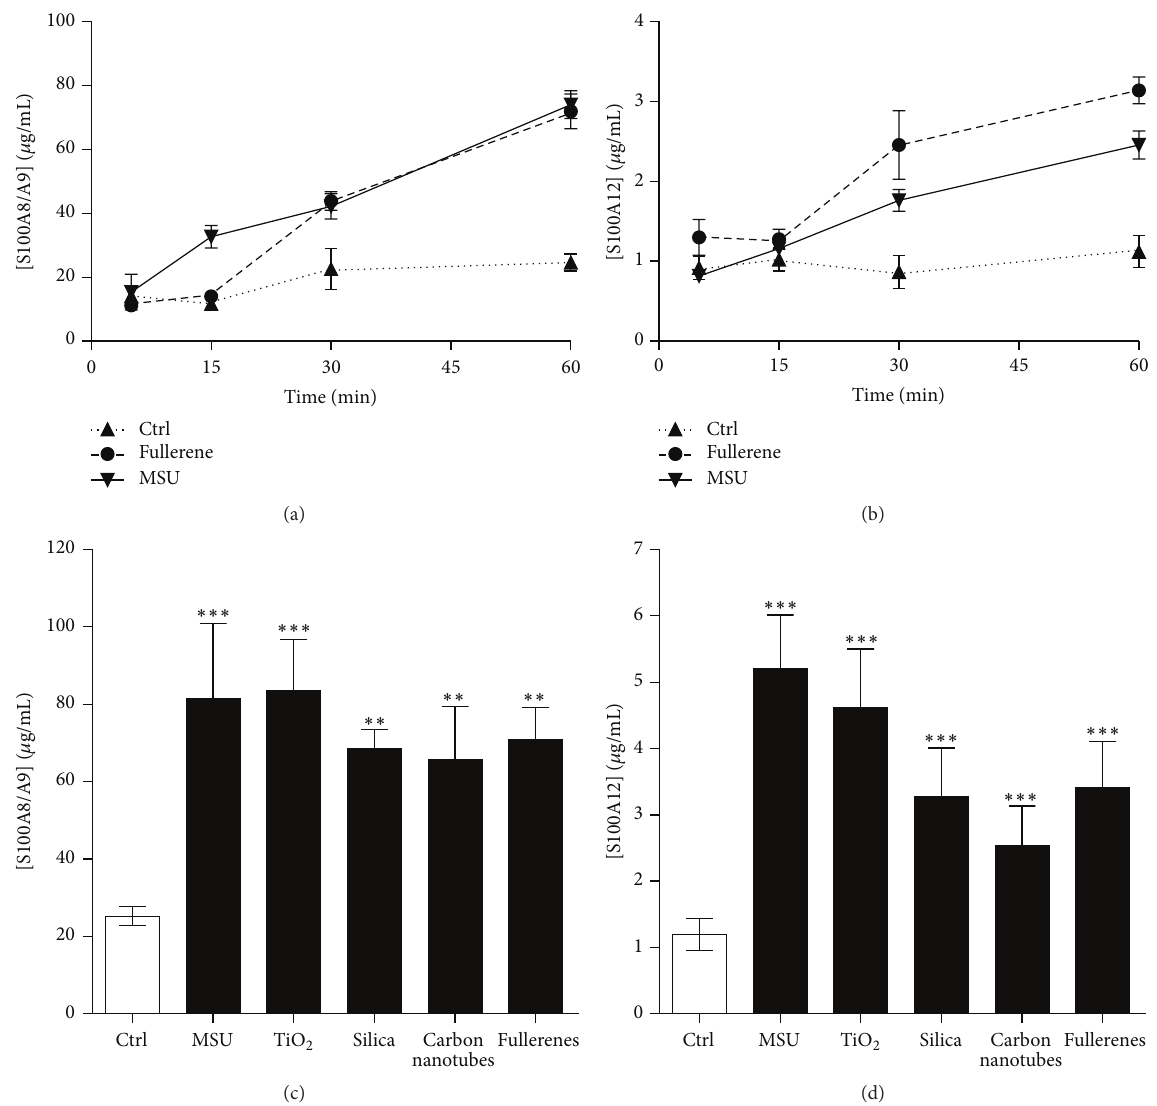
Figure 4: Phagocytic particles induce the secretion of S100A8/A9 and S100A12. Neutrophils were stimulated with 1.5mg/mL MSU crystals or fullerenes for increasing periods of time. (a) S100A8/A9 and (b) S100A12 in the supernatants were then quantified by ELISA. (c and d) Neutrophils were stimulated with 1.5mg/mL MSU crystals, 1.5mg/mL TiO 2 , 3 mg/mL silica, 1.5 mg/mL carbon nanotubes, or 1.5mg/mL fullerenes for 60 minutes. (c) S100A8/A9 and (d) S100A12 in the supernatants were then quantified by ELISA. Results represent the means ± SEM of 5 donors. ∗∗ 𝑃 < 0.01 ; ∗∗∗ 𝑃 < 0.001